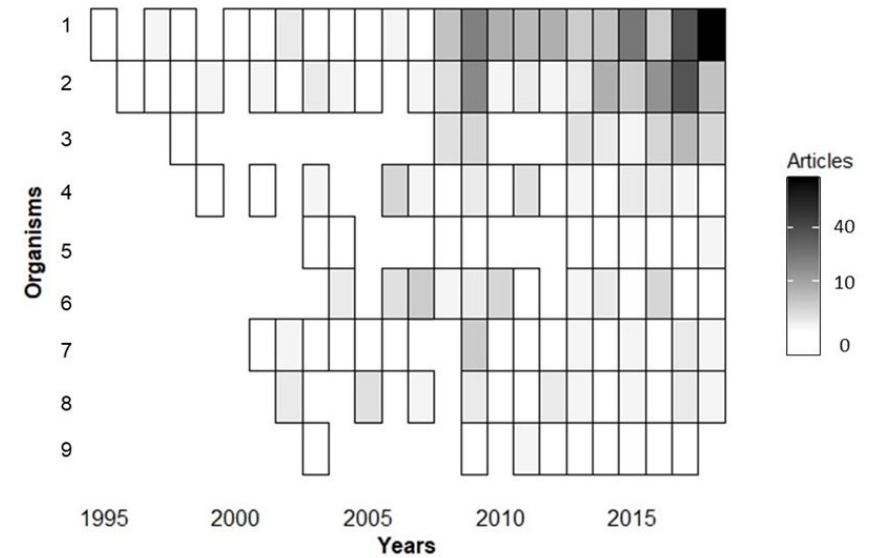
Figure 7. Number of articles about different taxonomic groups published from 1995 to 2018 found on the Web of Science (ISI) database. 1. Fish, 2. Protozoa and Invertebrates, 3. Algae, 4. Macrophytes, 5. Riparian vegetation, 6. Vertebrates, 7. Parasites, 8. Various taxonomic groups, 9. Other (bacteria, fungi, and